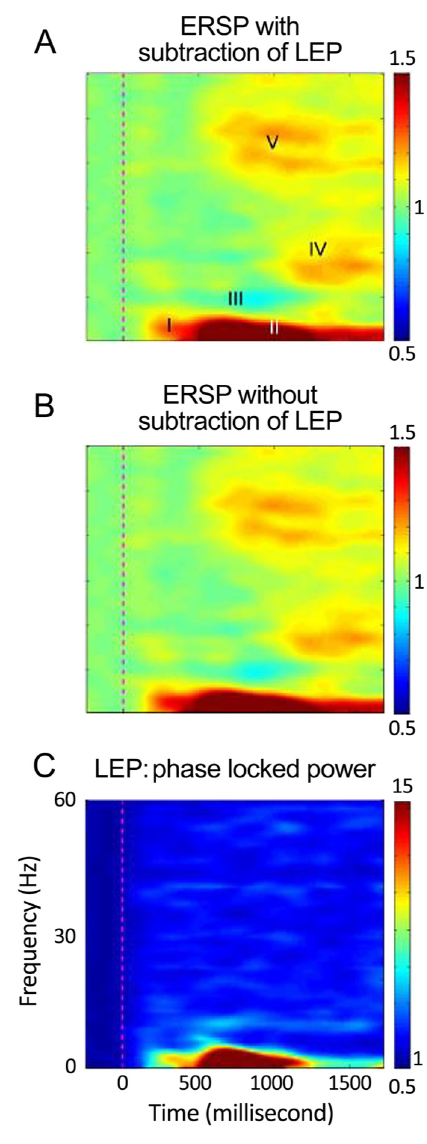
Figure 5. Time-frequency plots of activity in response to the laser pulse. Upper image ( A ): ERS / ERD induced by the laser during the attend laser task averaged across all subjects and channels with subtraction of phase-locked activity. The middle image ( B ) is without subtraction; while the lowest image ( C ) is the plot for ERP evoked by for the LEP. Other conventions as in Figure 4. Adapted from [88] .